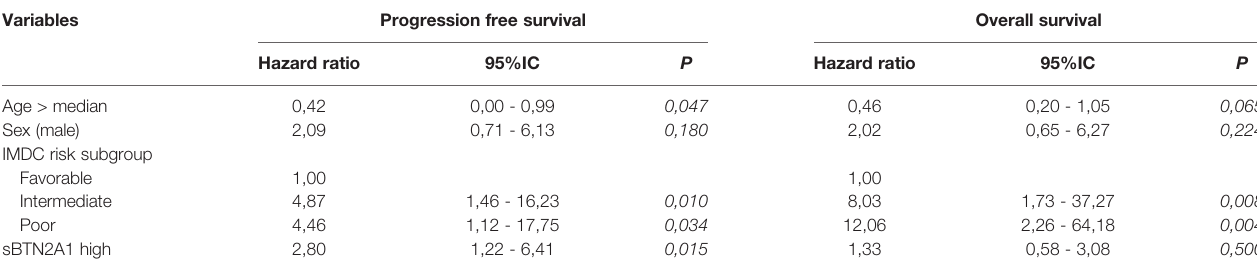
TABLE 3 | Multivariate hazard ratio for PFS and OS.